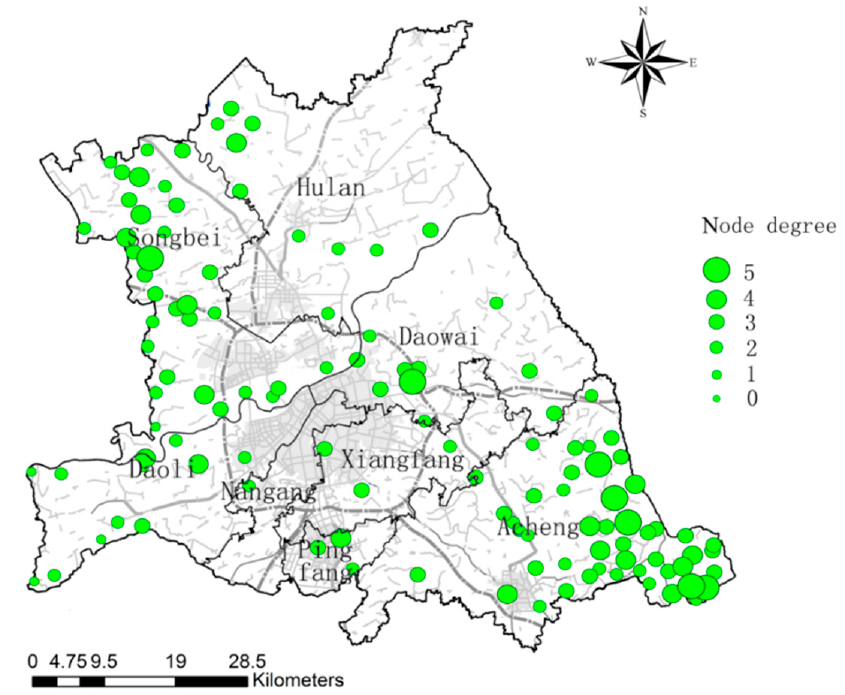
Figure 11. Ecological node degree distribution in the study area after optimization.